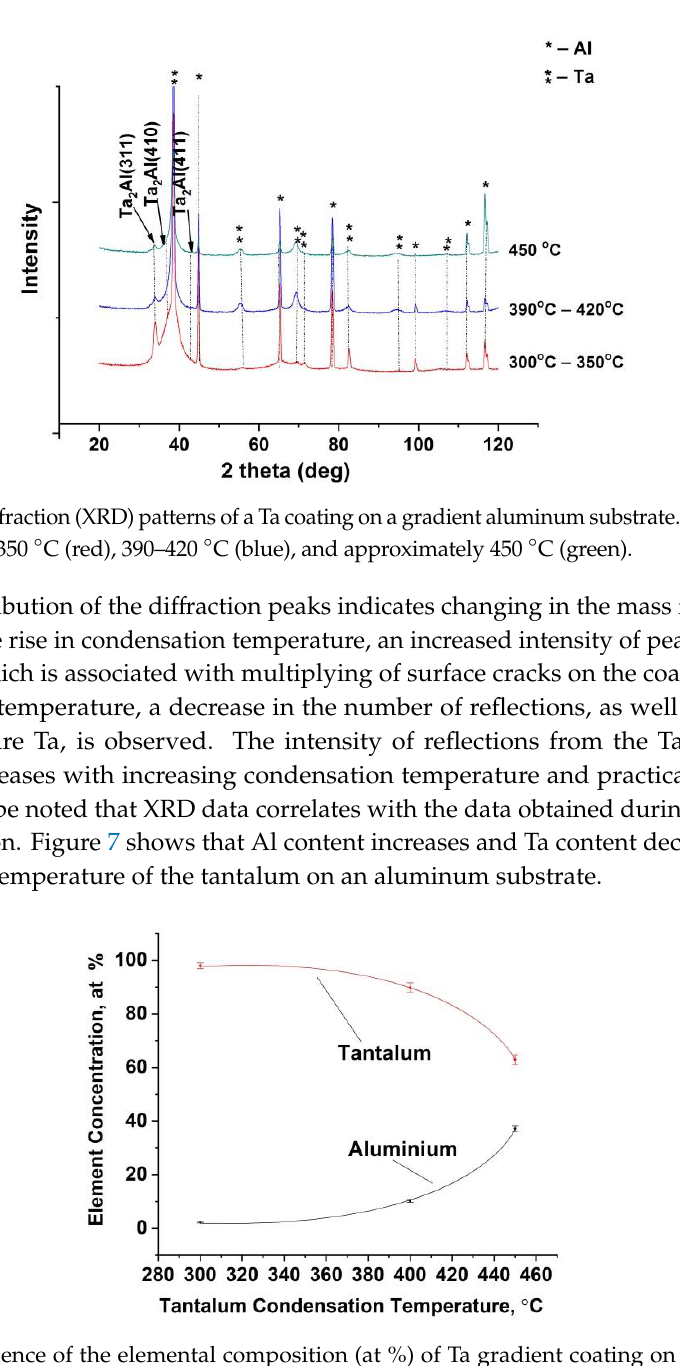
Figure 7. Dependence of the elemental composition (at %) of Ta gradient coating on an aluminum substrate formed at different temperatures.